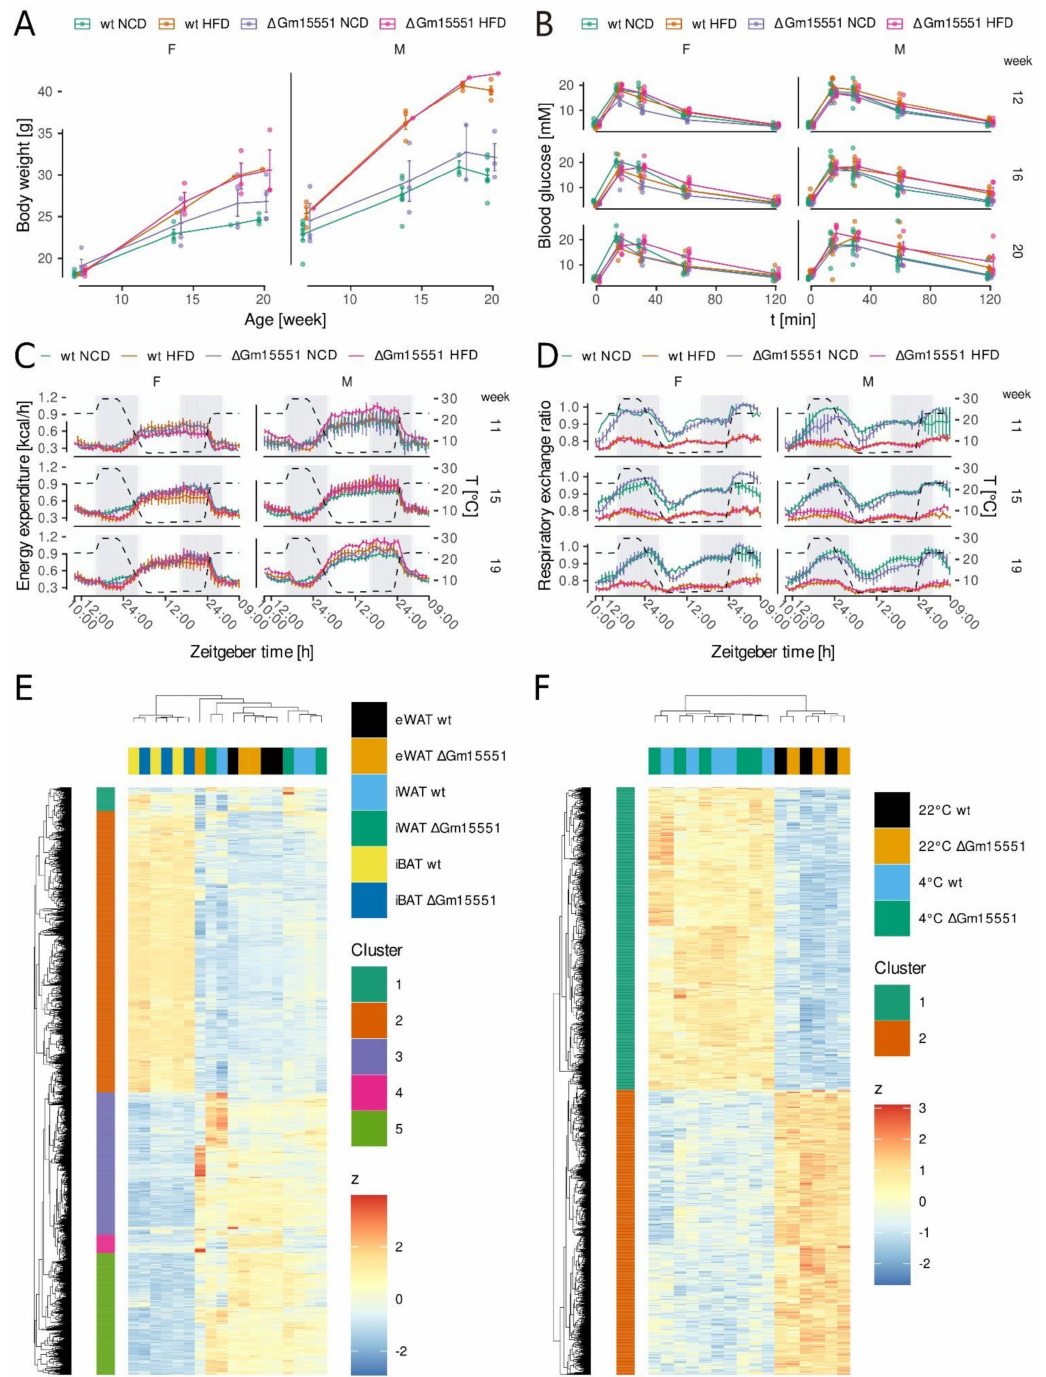
Figure 4. Gm15551 is dispensable for iBAT function in vivo. ( A ) Body weight of ∆ Gm15551 and wild type mice fed a high fat or control diet. ( B ) Intraperitoneal glucose tolerance test (IPGTT) of 12-, 16-, and 20-week-old ∆ Gm15551 and wild type mice fed HFD or NCD. ( C , D ) Energy expenditure ( C ) and respiratory exchange rates ( D ) of 12-, 16-, and 20-week-old ∆ Gm15551 and wild-type mice fed HFD or NCD. ( E ) Hierarchical clustering of genes differentially regulated between adipose tissues or by knockout of Gm15551 in 12-week-old mice (LRT, n = 3, p < 0.001). ( F ) Hierarchical clustering of genes differentially regulated by temperature or by knockout of Gm15551 in in iBAT of 12-week-old mice (LRT, n = 3 or 5, p <